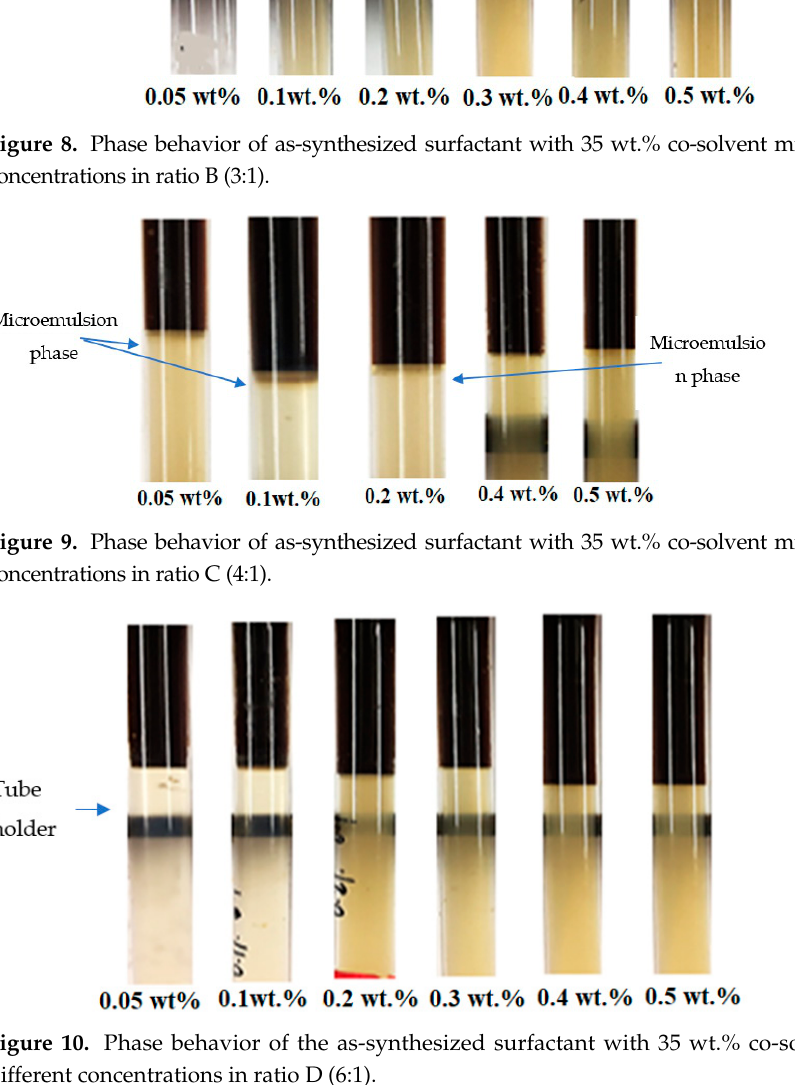
Figure 10. Phase behavior of the as-synthesized surfactant with 35 wt.% co-solvent mixture at dif- ferent concentrations in ratio D (6:1). 4. Conclusions The instability of the dynamic IFT and slightly cloudy appearance of as-synthesized oleic amido propyl betaine surfactant mixture with a long hydrophobic tail can be im- proved by adding EGME and DGME. The appearance issue needs to be solved before it